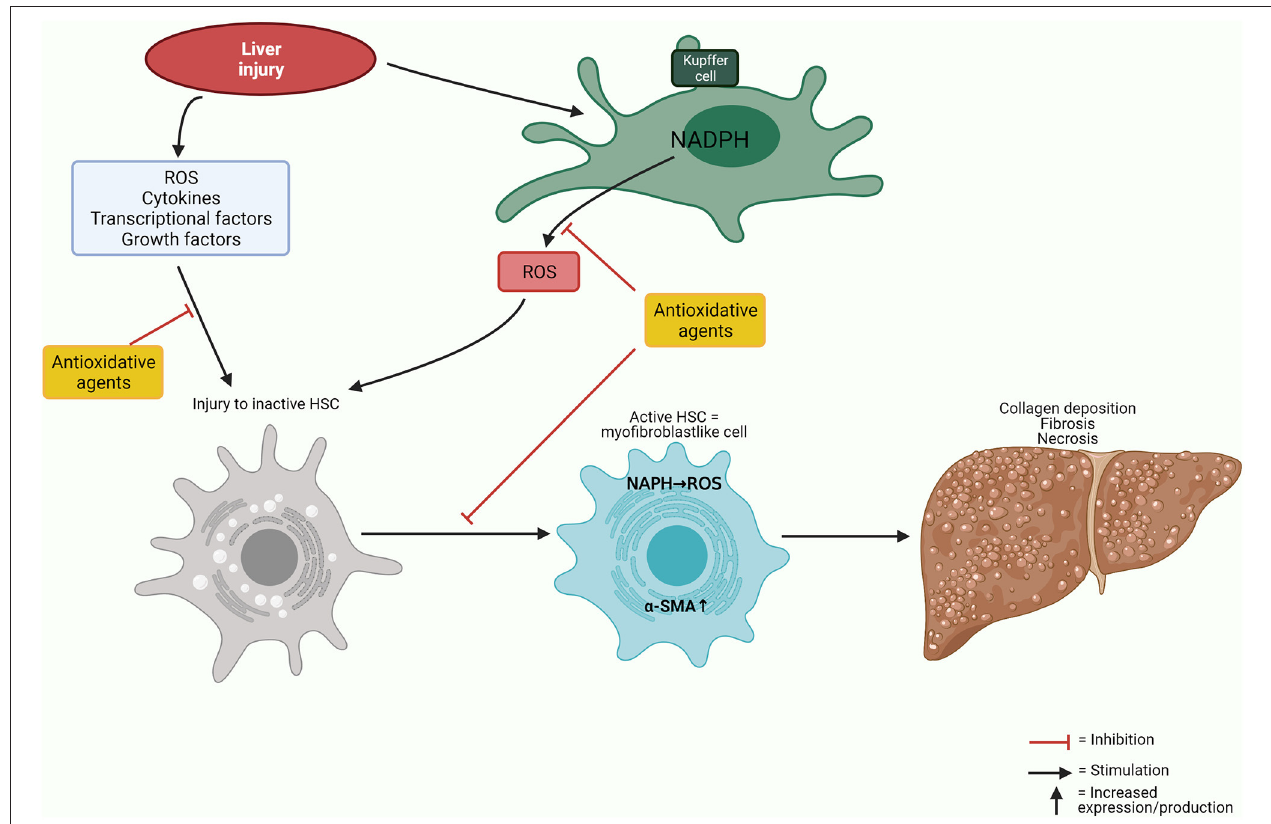
FIGURE 3 | Antioxidative mechanisms. Simplified illustration of oxidative and antioxidative mechanisms affecting liver cells. α -SMA, α -smooth muscle actin; HSC, hepatic stellate cell; NADPH, nicotinamide adenine dinucleotide phosphate; ROS, reactive oxygen species.